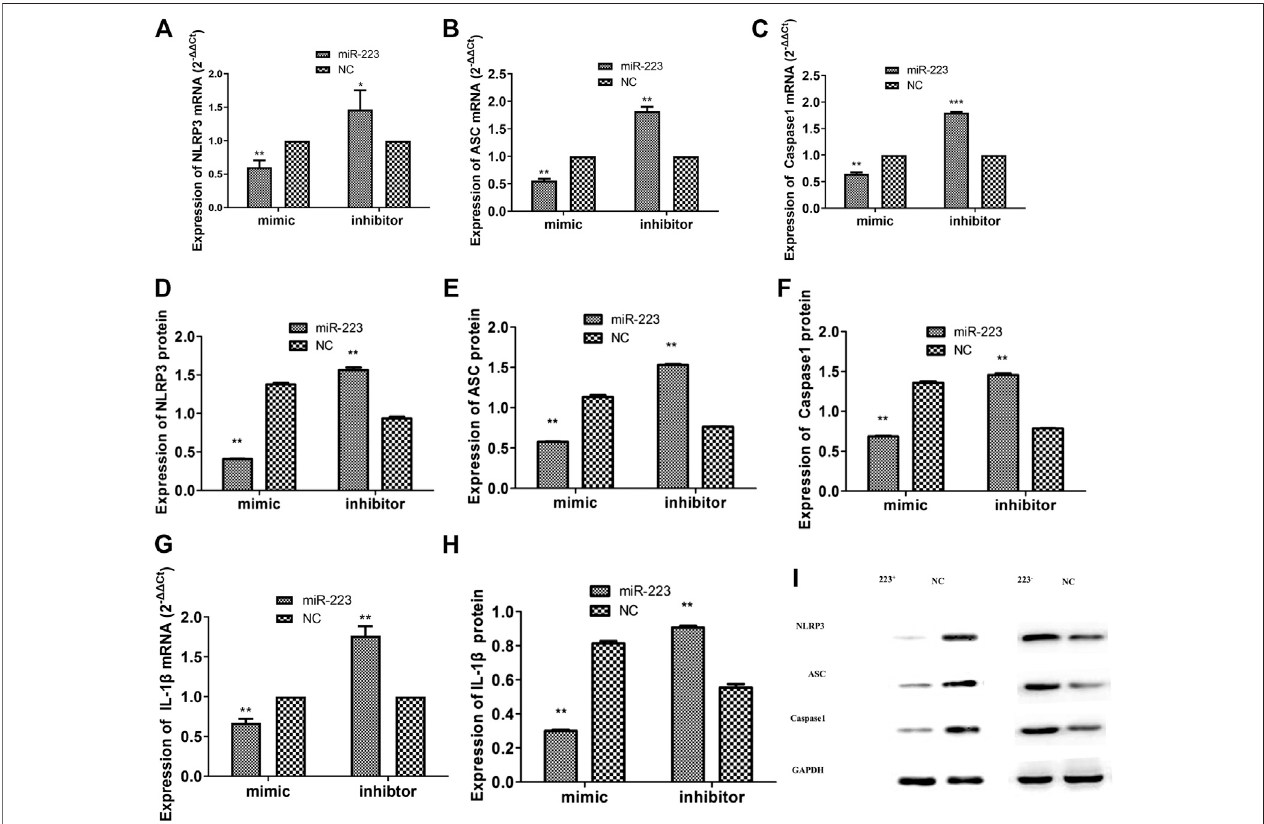
FIGURE 5 | Effect of miR-223 on expression of the NLRP3 in fl ammasome and IL-1 β in RAW264.7 macrophages treated with MSU. Over-expression of miR-223 signi fi cantly decreased the mRNA and protein expression levels of the NLRP3 in fl ammasome (NLRP3, ASC and caspase-1) and IL-1 β in comparison with the miRNA negative controls in RAW264.7 macrophages. In contrast, miR-223 inhibitors signi fi cantly increased the mRNA and protein expression levels of the NLRP3 in fl ammasome and IL-1 β in comparison with the miRNA negative controls in RAW264.7 macrophages (* p < 0.05, ** p <